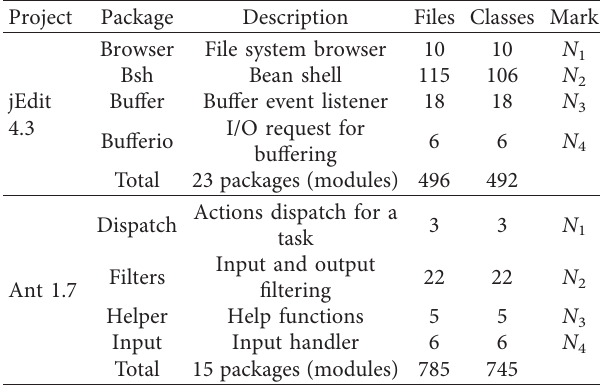
Table 3: Metric division in this study.